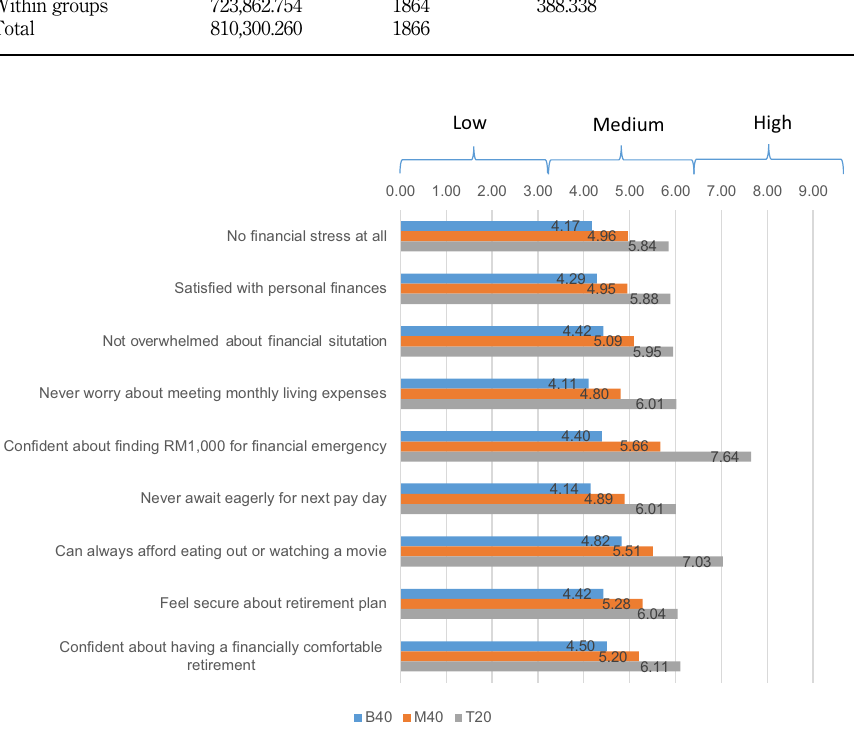
Figure 1. Scores of FWB by item